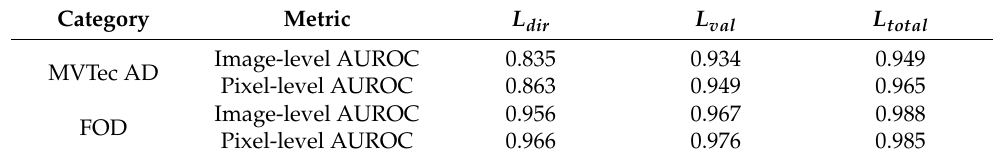
Table 6. The results of MSFI using different loss functions on the MVTec AD and FOD